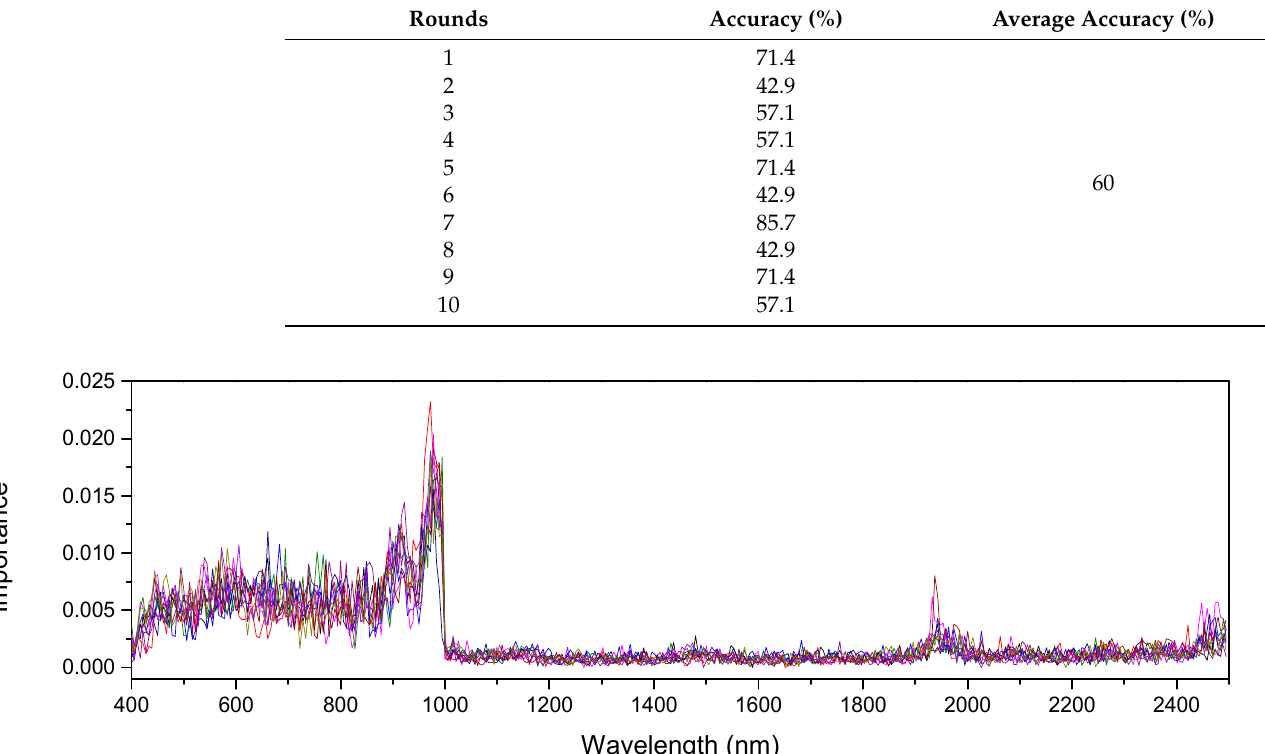
Figure 4. The importance of spectral band under one year classification scale provided by random forest. The colorful curves have ten colors in total from experiments repeated 10 times.